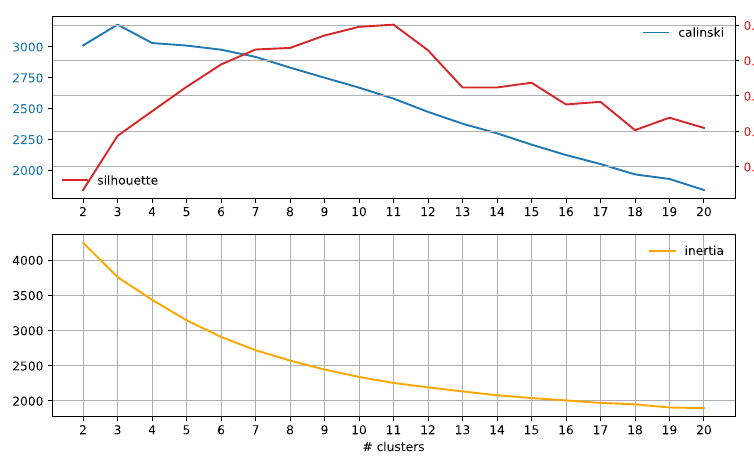
Figure A15. Subreddit CrohnsDisease.